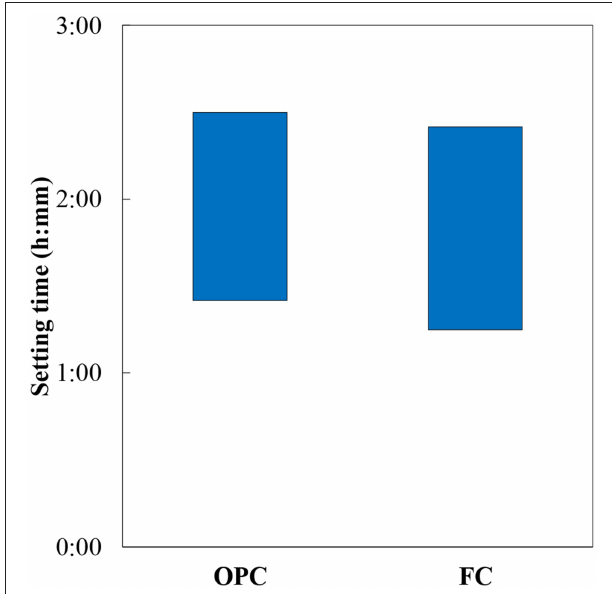
FIGURE 5 | Initial and final setting times of hydrated cements.